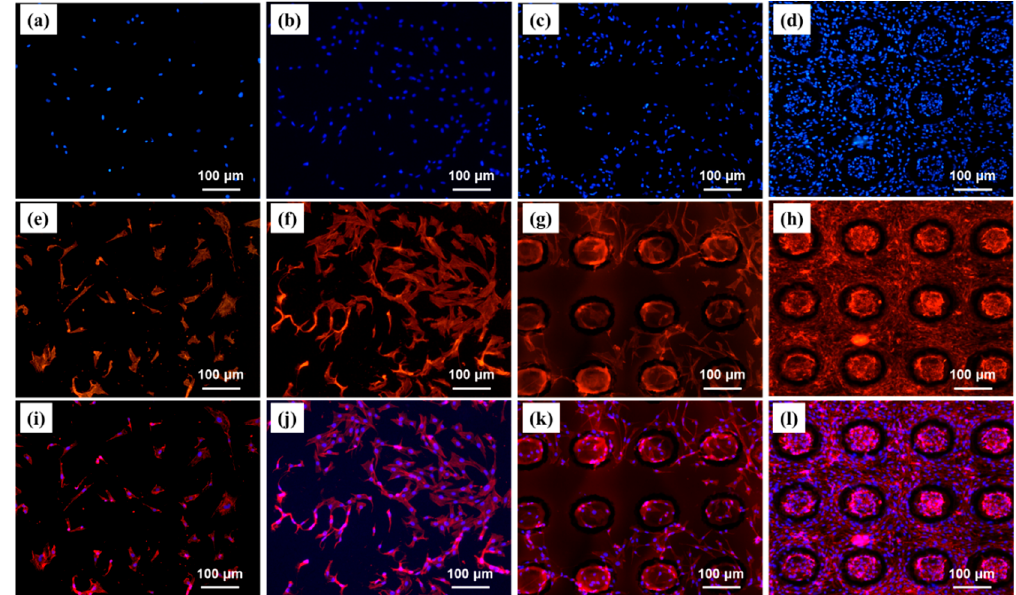
Figure 12. Fluorescence microscope images of cultured MC3T3-E1 cells after seeding for 48 h: ( a , e , i ) Polished CoCrMo, ( b , f , j ) Co-S, ( e , g , k ) Co-T, and ( d , h , l ) Co–T–S. From top to bottom, nuclear stained cells, actin stained cells, and the two merged cells, respectively.